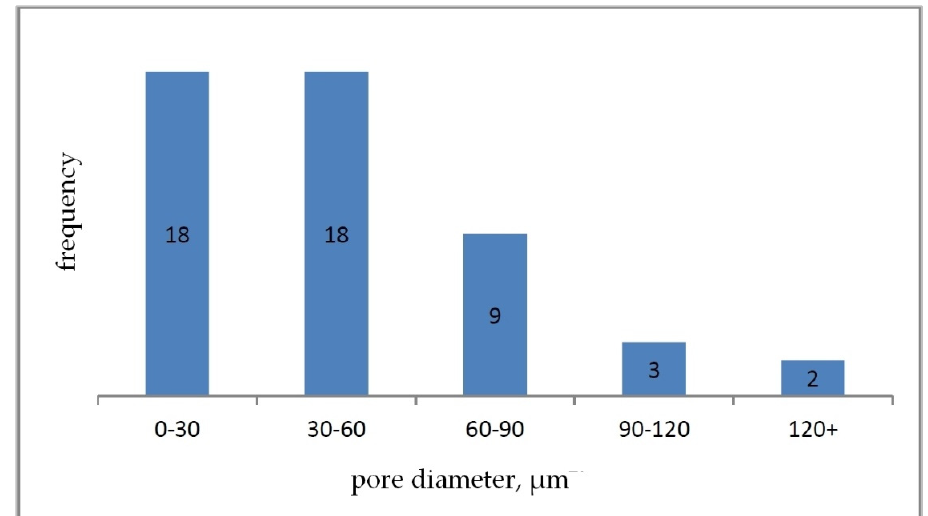
Figure 11. Pore size histogram for carbon sample M1.